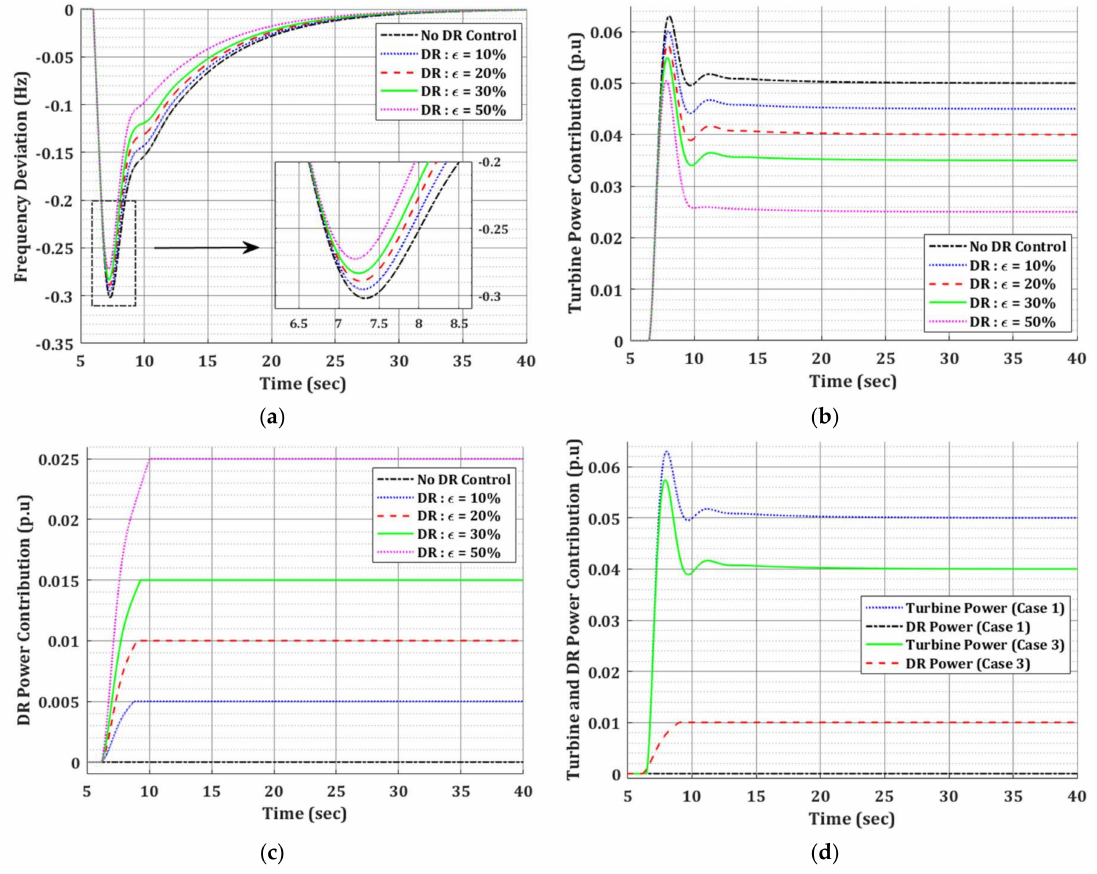
Figure 4. Effect of DR control share ( ε ) on various system parameters under load disturbance: ( a ) system frequency response; ( b ) change in turbine power (p.u); ( c ) change in DR power (p.u); and ( d ) change in turbine and DR powers (p.u) for selected